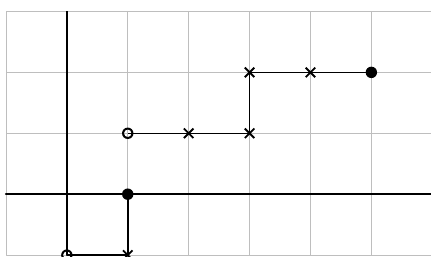
Figure 8. Generating function of the exponential factor in the realization of the fundamental representation in the (cid:12)rst direction at level